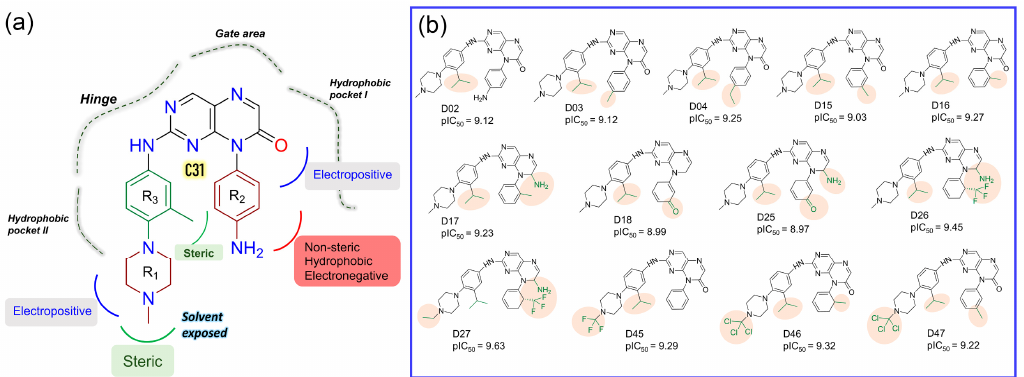
Figure 5. SAR study and development of new compounds. ( a ) The summary of the structure-activity relationship from the CoMFA and CoMSIA analyses around the reference compound C31. ( b ) Designed compounds with higher predicted pIC 50 in the CoMSIA model. The substitution sites are highlighted in the pale salmon color.